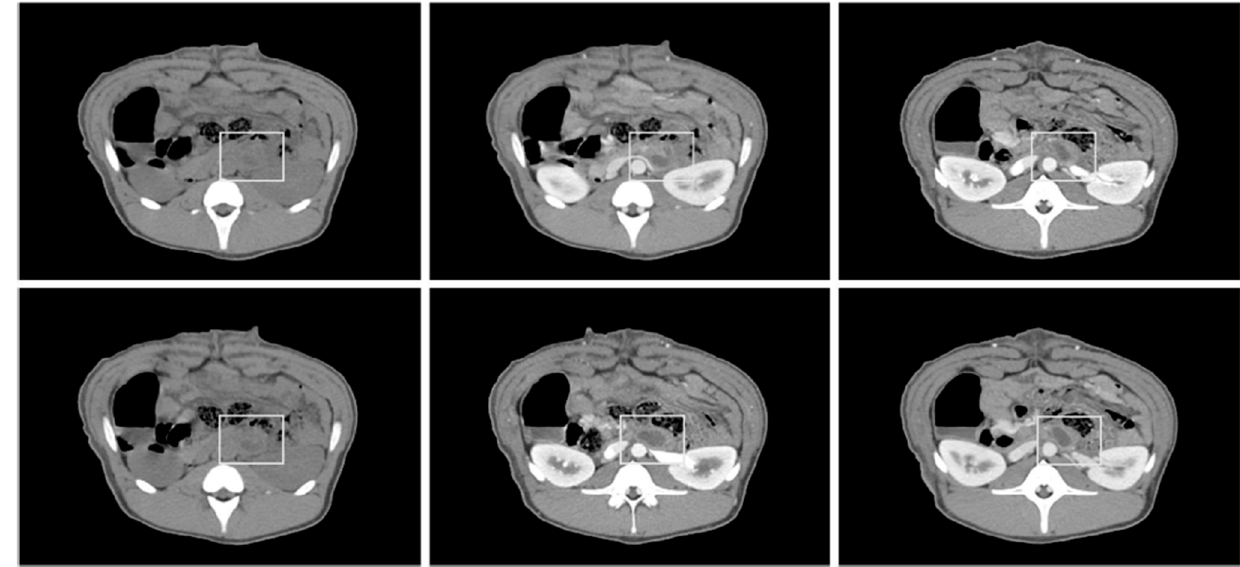
Figure 2. Computed tomography non-contrast (left) image and early (center) and delayed (right) phases of contrast-enhanced CT images: Images showed no evidence of perforation, hemorrhage, ascites, adjacent structural injury, or peri-pancreatic fluid collection. Images showed a solid, low- density lesion in EUS-CILA-treated region (white